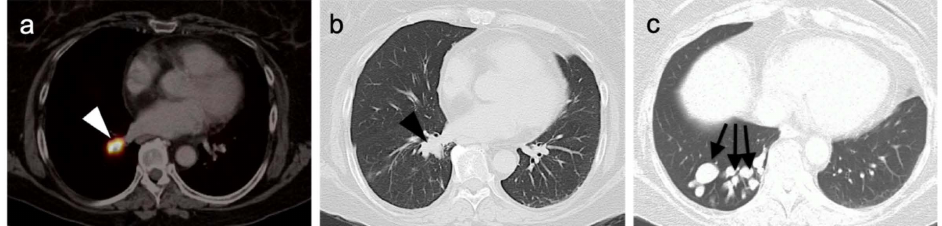
Figure 42. Typical pulmonary carcinoid and associated bronchoceles. ( a ) Axial [ 64 Cu]Cu-DOTA- TATE (Detectnet ® ) PET-CT shows the markedly PET-positive bronchial lesion in the right infrahilar region (white arrowhead), consistent with a well-differentiated (typical) bronchial carcinoid tumor. ( b ) Axial CT shows the location of the lesion that was positive on PET-CT (black arrowhead). ( c ) Axial CT shows bronchoceles (black arrows) related to dilated fluid-filled airways, a frequent finding with pulmonary carcinoids (these bronchoceles showed no uptake on SSTR